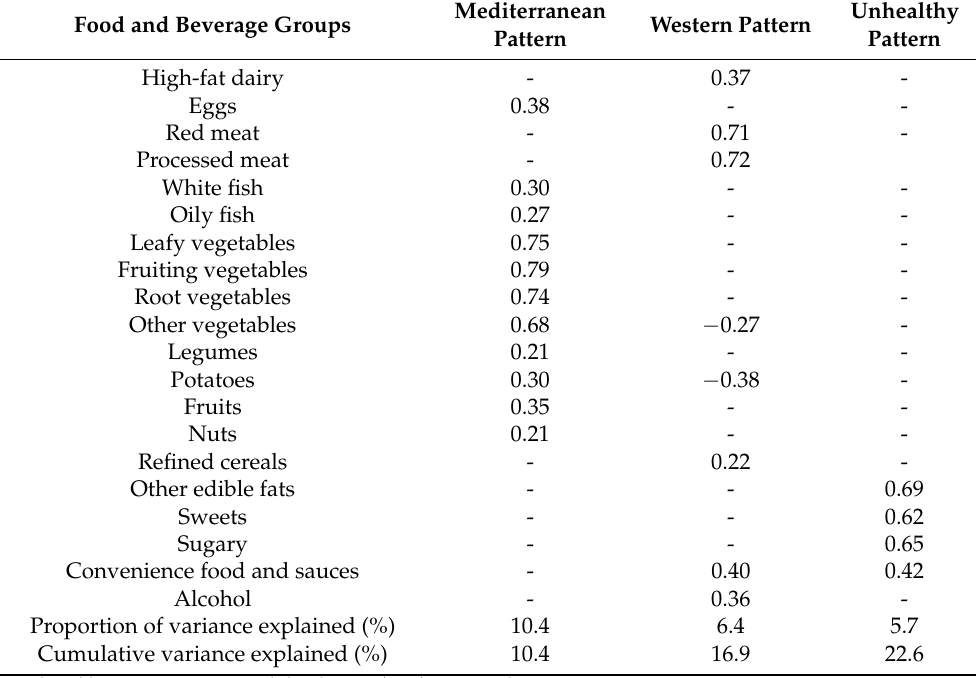
Table 2. Rotated factor loadings and explained variances for 3 main dietary patterns identified by principal component